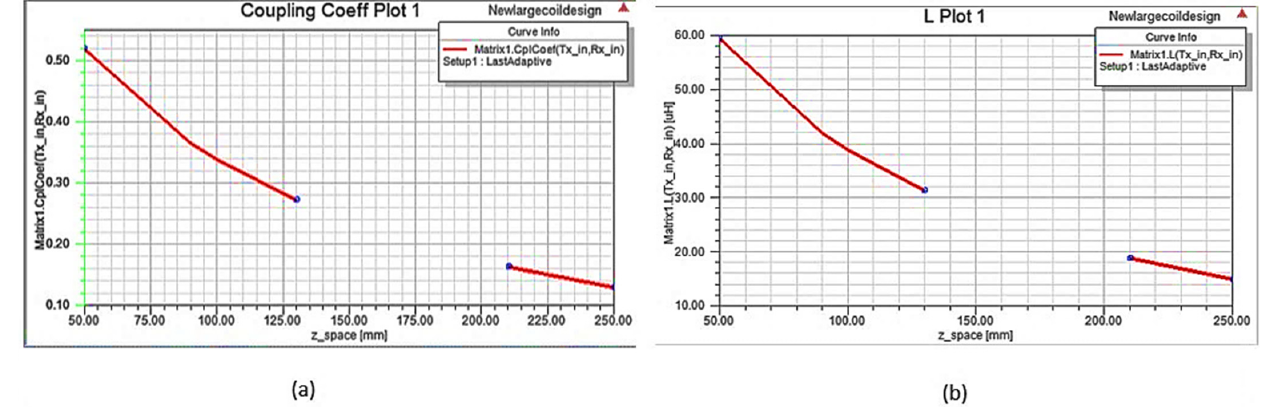
Figure 8. Results for 120 mm square coil: ( a ) mutual inductance vs. air gap spacing (mm), ( b ) cou- pling coefficient vs. air gap spacing (mm).